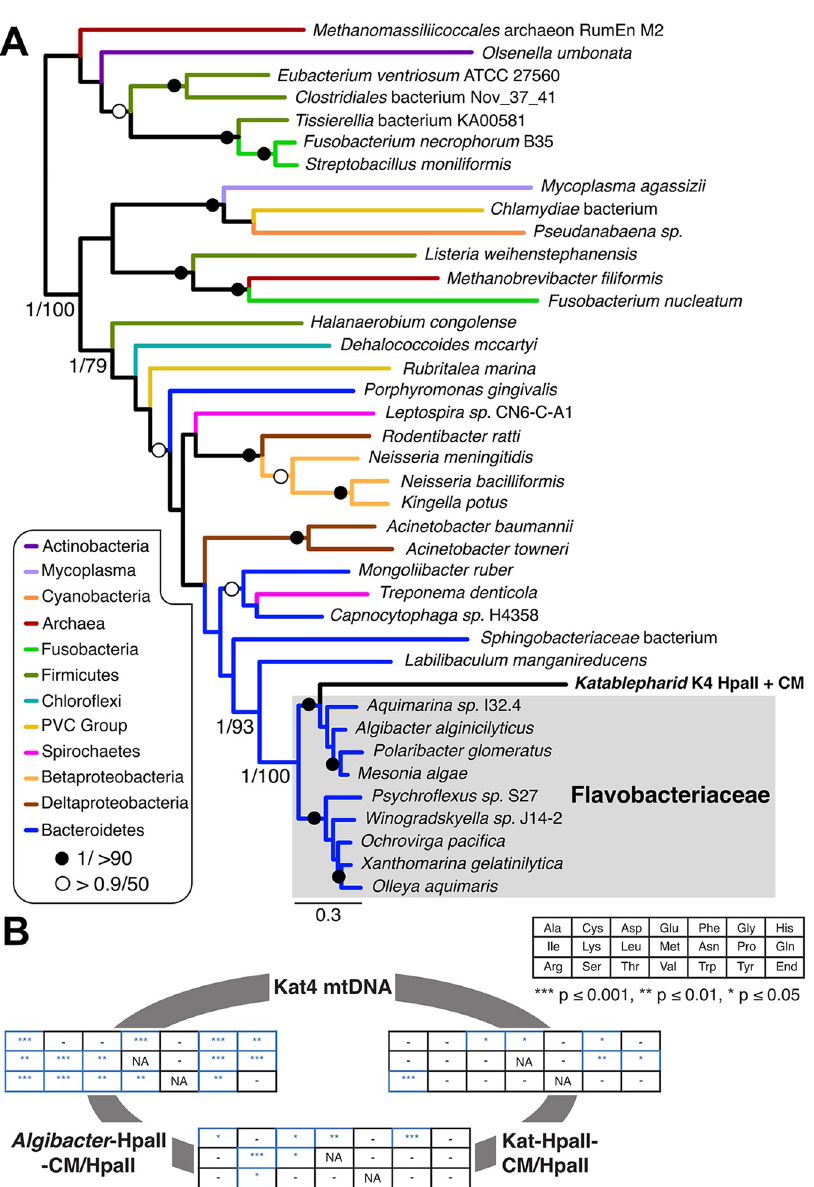
Fig 2. Phylogenetic reconstruction of concatenated genes encoded by katablepharid RM selfish elements and comparison of codon frequencies between katablepharid and Algibacter complements. (A) A concatenated phylogeny was reconstructed using sequences from K4 and 38 prokaryotic species containing tandemly encoded HpaII-CM and HpaII proteins. The concatenation resulted in an alignment length of 767 amino acid positions. Support values are posterior probabilities calculated using MrBayes v3.2.6 [34] and 100 bootstrap replicates using RAxML v8.2.10 [35] and reported as MrBayes/RAxML. The MrBayes topology is shown. Species phyla are indicated as differently coloured branches as depicted inset. Bipartitions with support lower than 0.9/50 are unlabelled. For individual trees of HpaII and HpaII-CM, see S1 Fig . Alignment data available at http://doi.org/10.6084/m9.figshare.c. 5336963. (B) Pairwise comparisons of sets of alternative codon frequencies for Kat4-HpaII-CM/HpaII, Algibacter - HpaII-CM/HpaII, and the conserved protein-coding gene repertoire of the Kat4 mtDNA. Pairwise comparisons are shown in the respective grids. The key shows a grid with the corresponding amino acids. Results for Fisher exact tests comparing codon usage for each amino acid are shown in the tables. Asterisks denote significantly different codon usage, “-” indicates no significant difference in codon frequencies, and “NA” indicates methionine and tryptophan, which were not tested as these amino acids are encoded by a single codon. Grids are placed on a grey circle between the three compared gene sets to identify the results of each pairwise comparison. Raw data available in S2 Data . mtDNA, mitochondrial DNA; RM, restriction